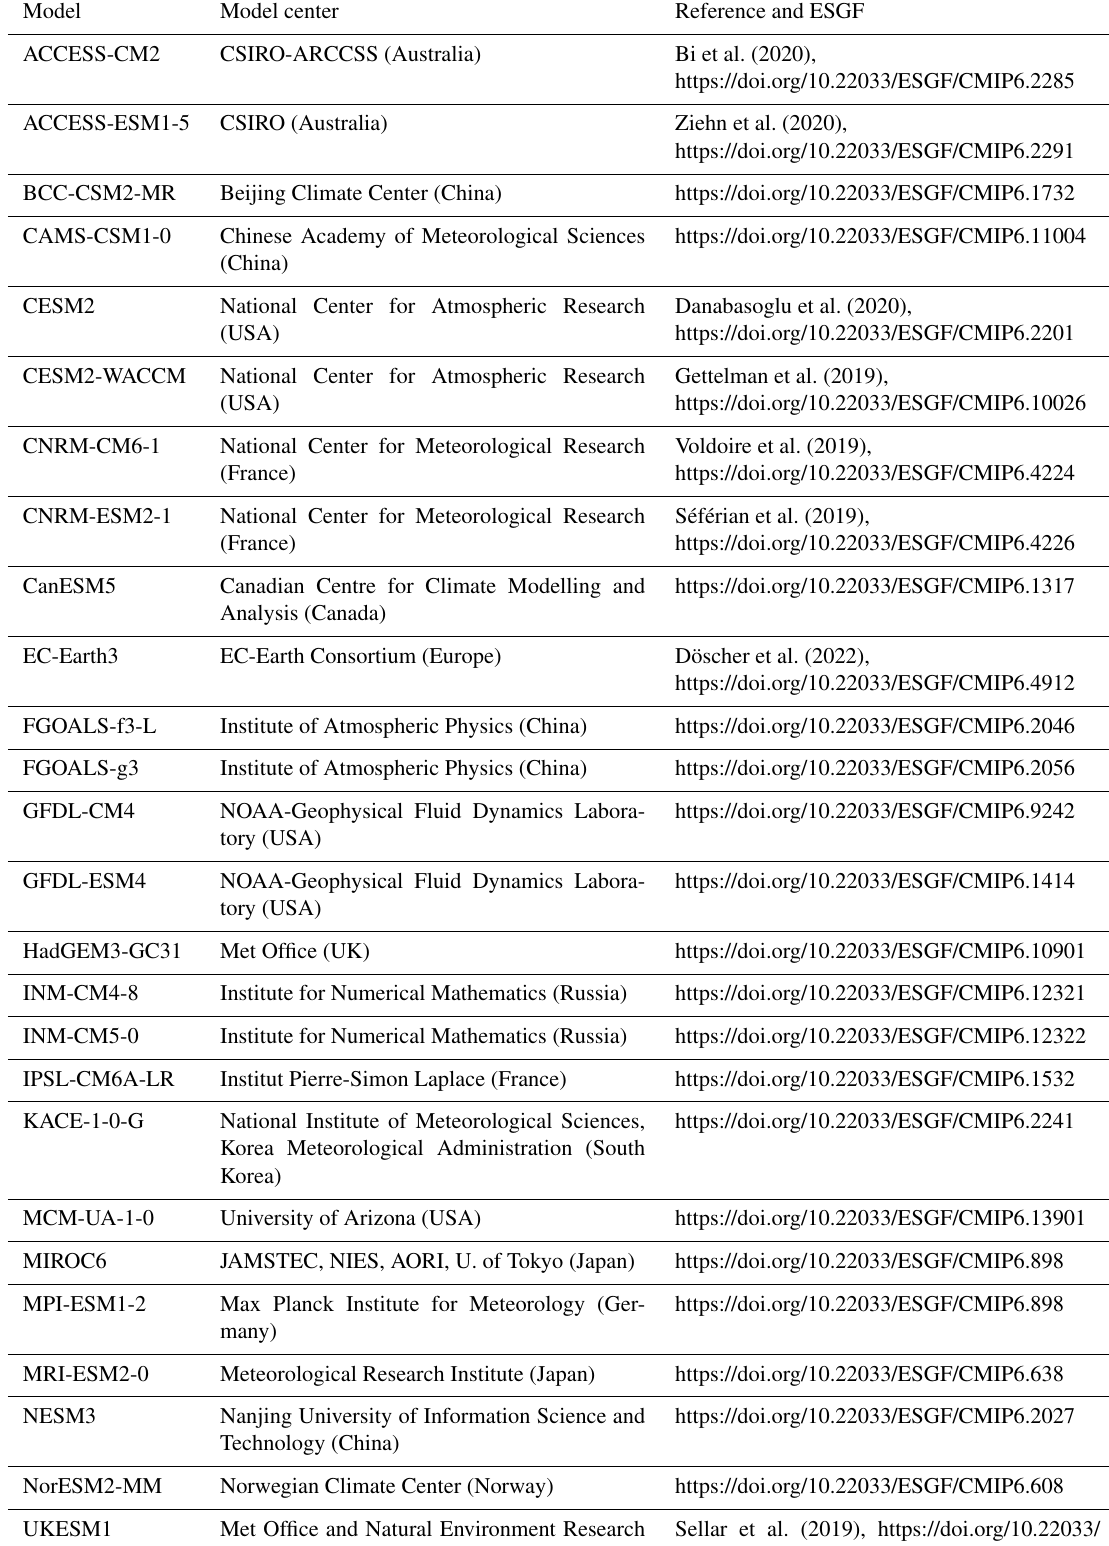
Table A1. The list of the CMIP6 models from which the historical experiments and ScenarioMIP experiments are adopted in this study through the Earth System Grid Federation